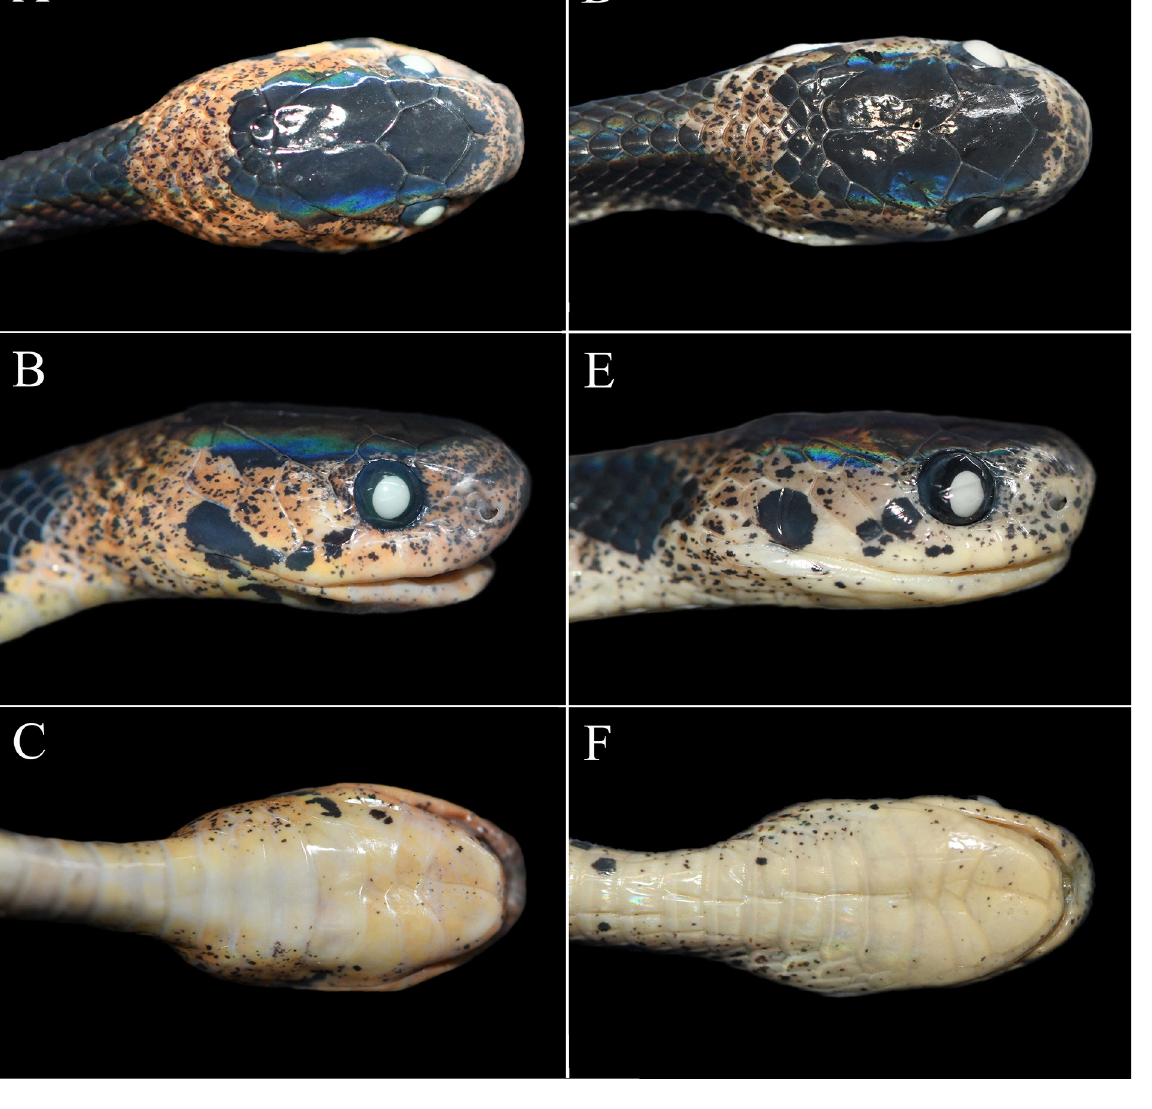
Fig. 6. Pareas tigerinus sp. nov. in preservative, head. A–C . Holotype, ♀ (KIZ 20210705). A . Dorsal view. B . Lateral view. C . Ventral view. D–F . Paratype, ♂ (KIZ 20210703). D . Dorsal view. E . Lateral view. F . Ventral view. Photos by S.